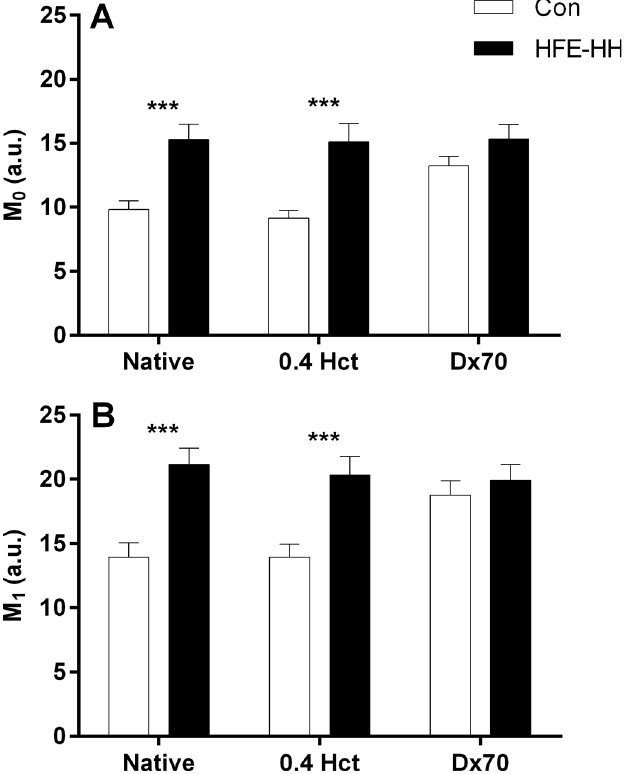
Fig 2. Red cell aggregation for haemochromatosis (HFE-HH) patients and healthy controls (Con) measured in plasma suspensions at native and a standardised (0.4 L/L) haematocrit, and red cell aggregability in a standard aggregating medium (Dx70). Red cell aggregation was increased for HFE-HH when compared with Con while at stasis ( “ M 0 ” ; Panel A) at native and standardised haematocrit. The same observation was made for aggregation measures at low-shear ( “ M 1 ” ; Panel B). Red cell aggregability was not different between groups at stasis or low-shear. *** , HFE-HH significantly increased compared with Con, p <